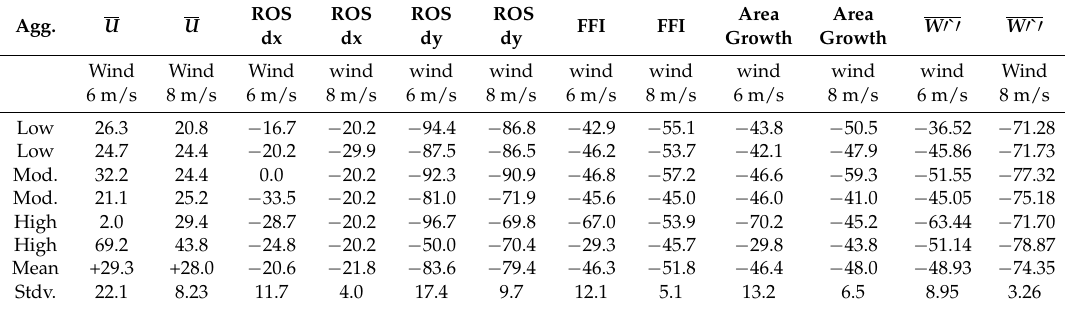
Table 3 . Percent change in fire behavior metrics, shown in Table 1, from 60% forest cover to 30% forest cover, for each of six metrics. Each metric is represented with two columns in which the left shows percent changes for medium wind cases and right shows percent changes for high wind cases. The left most column, “Agg.”, is an abbreviation of “aggregation” or scale of forest canopy clumping.